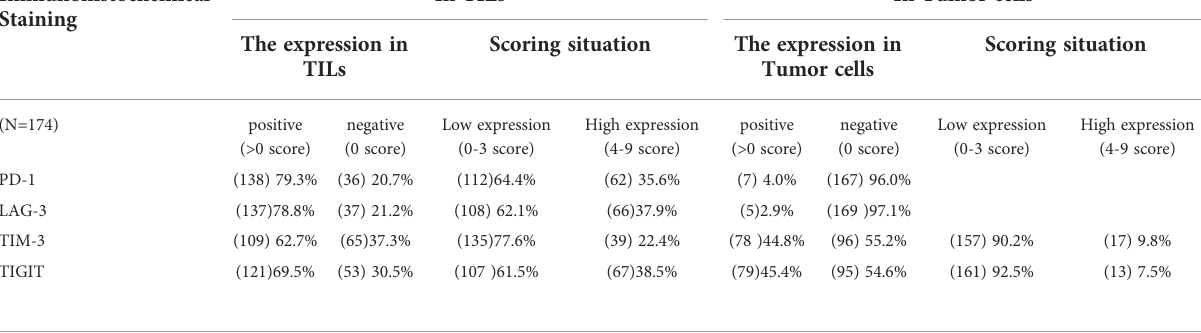
TABLE 2 IHC analysis of DLBCL